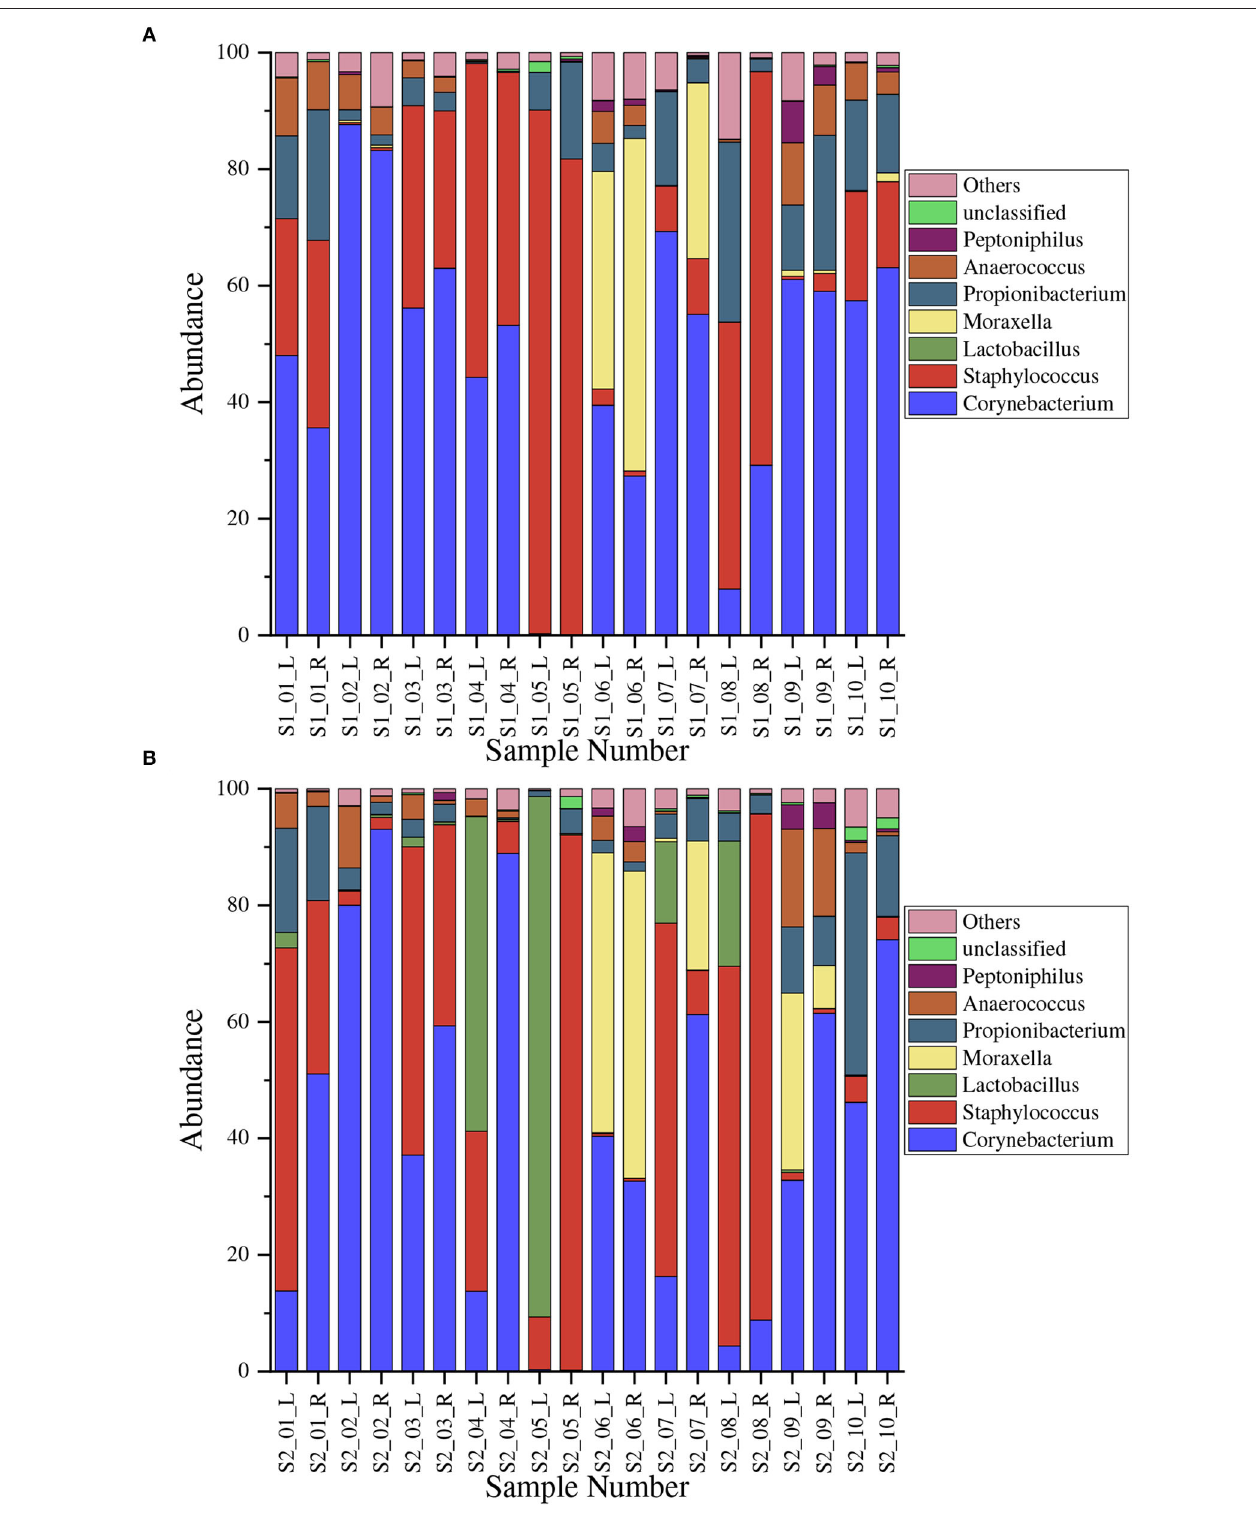
FIGURE 2 | Normalized proportional distribution of microbe genera in armpits. The horizontal axis denotes different samples; for example, S1_01_L denotes the result of the left armpit of the first volunteer before the treatment. (A) Before the treatment (Sample S1); (B) After the treatment (Sample S2).